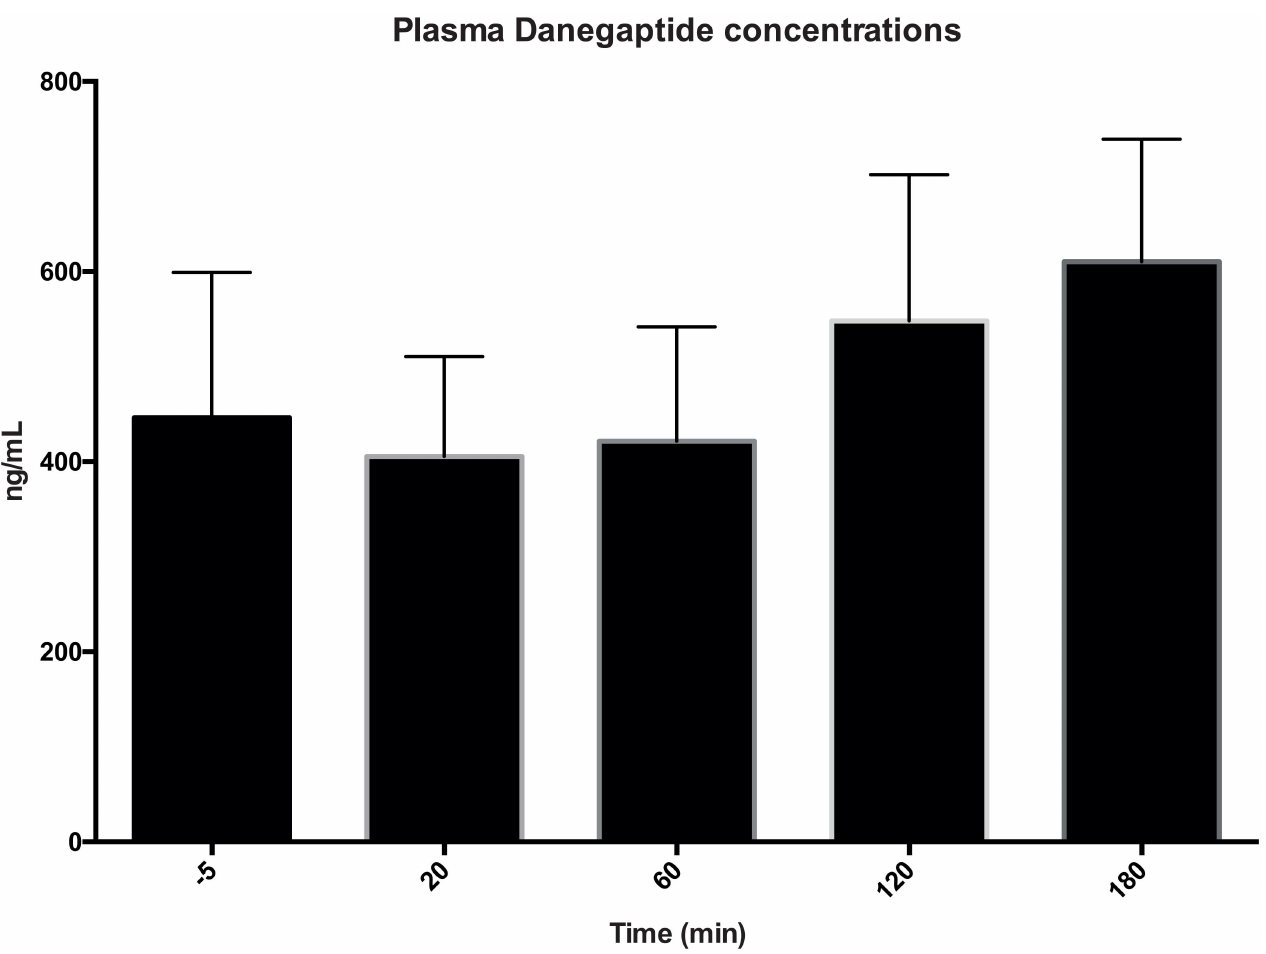
Fig 6. Plasma Danegaptide concentration: Measuredon day 1. Error bars represents 95% CI.